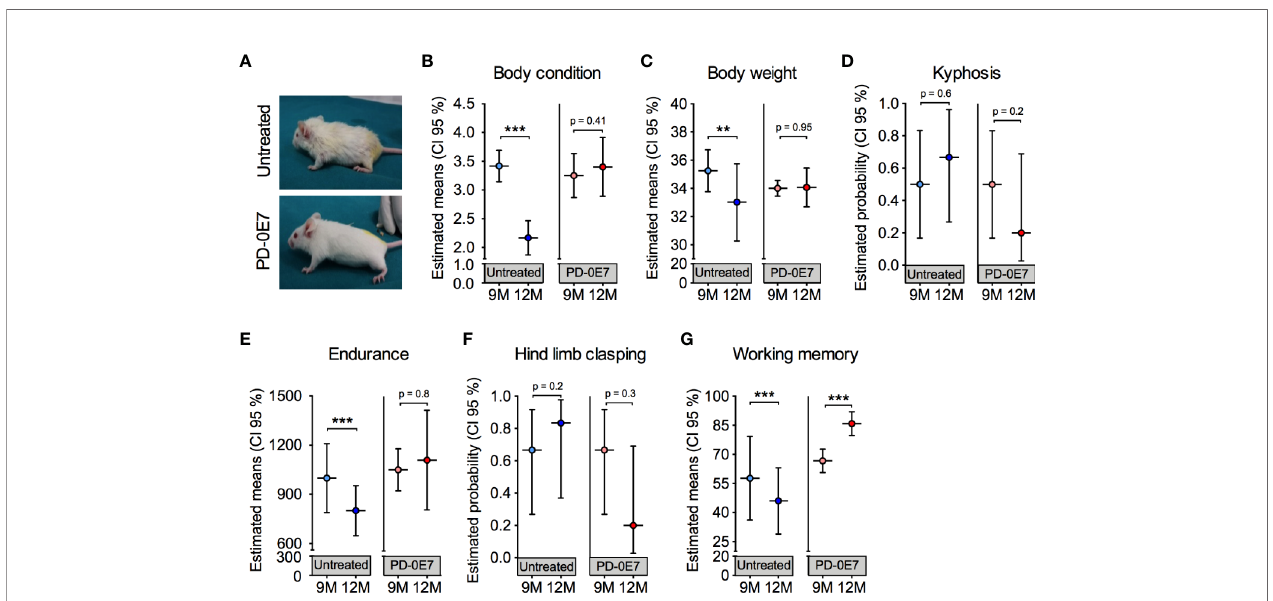
FIGURE 4 | Effect of PD-0E7 supplementation on muscular and cognitive function in aged SAMP8 mice. (A) Representative pictures of 12-month-old untreated and PD-0E7-treated mice. The ef fi cacy of the PD-0E7 was investigated in a longitudinal experiment comparing the behavioral scores of single mice at baseline (9M, 9 months of age) and after 3 months of supplementation (12M, 12 months of age). Control, untreated mice were also individually scored at baseline (9M) and after 3 months (12M). Treatment effects across time for body condition score (B) , body weight (C) , endurance capacity (E) , and working memory (G) means were analyzed with generalized estimating equation (GEE) with Gaussian error distribution. Frequency of kyphosis (D) and hind limb clasping (F) data were analyzed with GEE with binomial distribution. Error bars represent 95% con fi dence interval; n=6 mice/untreated group; 5 mice/PD-0E7-treated group, due to one death after baseline assessment. **p < 0.01; ***p <